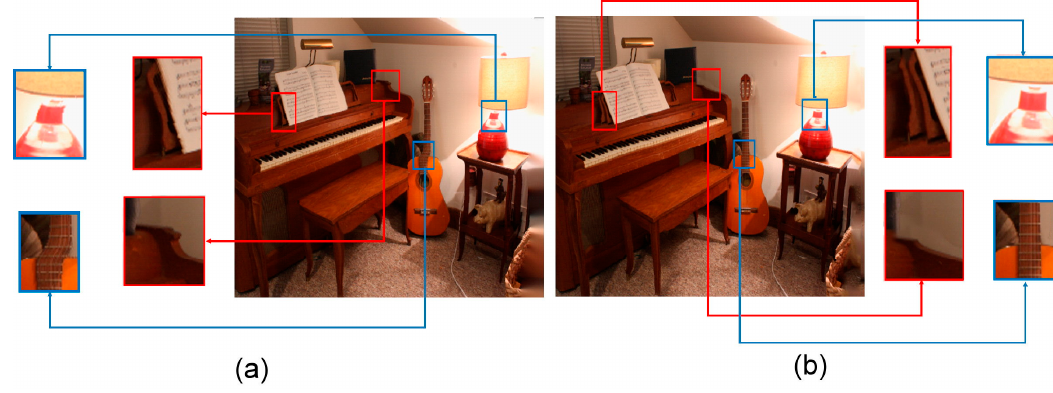
Figure 9. Comparison of the results obtained using ( a ) warping and ( b ) our model.